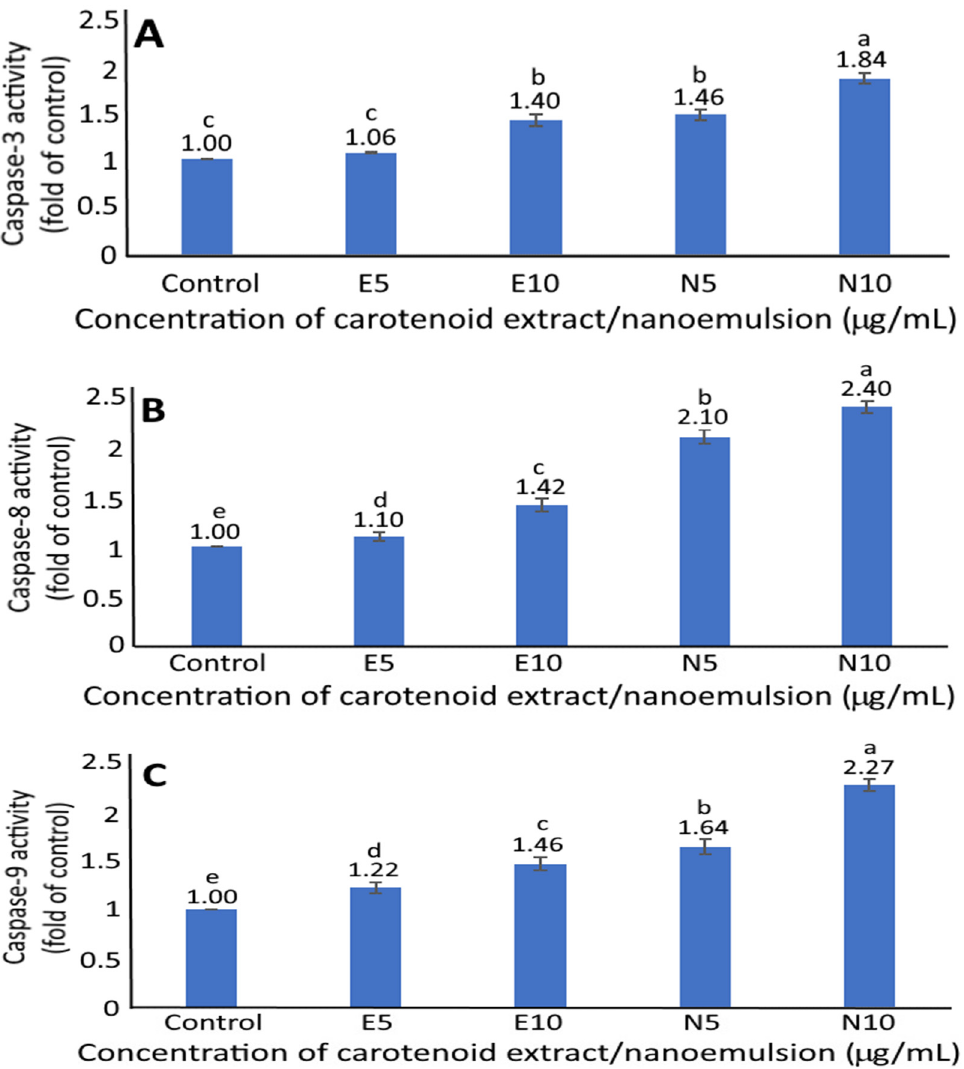
Figure 7. Effect of carotenoid extracts and nanoemulsions on caspase-3 ( A ), caspase-8 ( B ) and caspase-9 ( C ) activities of human breast cancer cell MCF-7. Control cells were incubated in medium only; E5 and E10, carotenoid extract concentration respectively at 5 and 10 μ g/mL; N5 and N10, carotenoid nanoemulsion concentration respectively at 5 and 10 μ g/mL. Results are presented as mean ± standard deviation of triplicate independent experiments. Data with different small letters (a–e) are significantly different at p < 0.05.